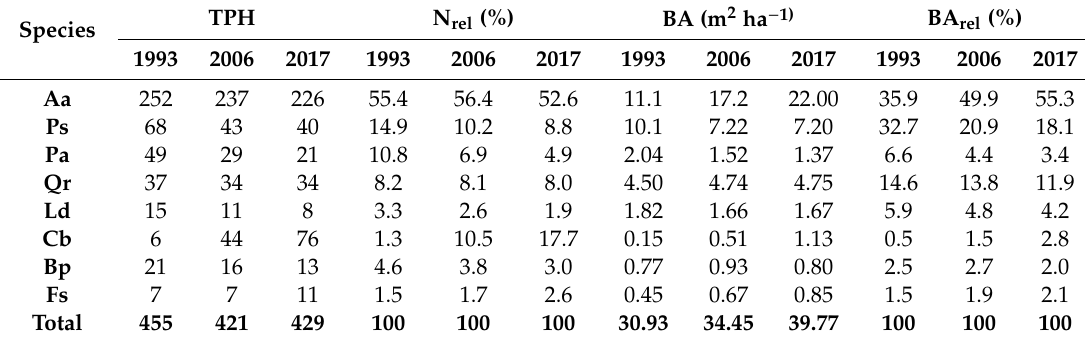
Table 1. Changes in density (TPH), basal area (BA), relative density (N rel ), and basal area (BA rel ) in the multispecies, uneven-aged forest in 1993, 2006 and